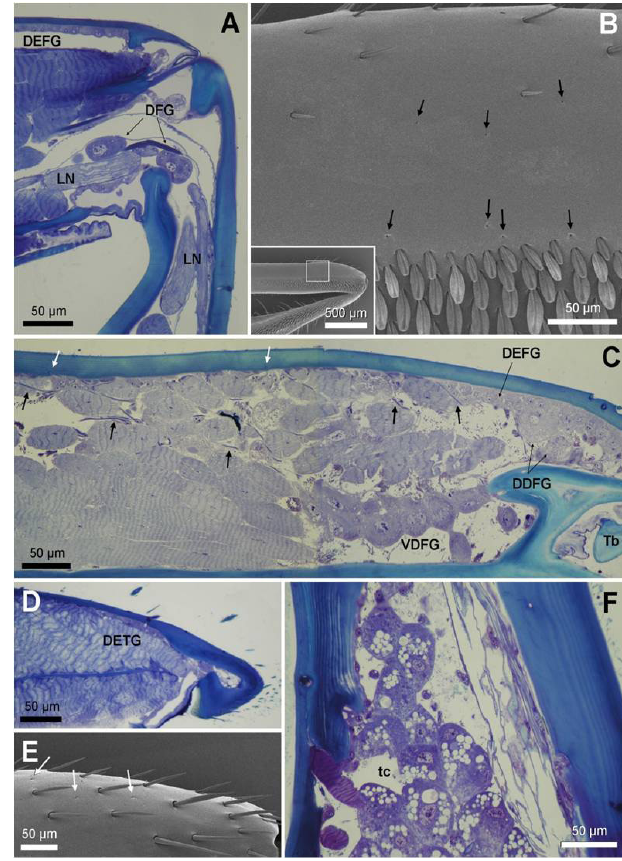
Fig 4 . A . Junction between midleg femur and tibia, showing the dor- sodistal epithelial femoral gland (DEFG) and distal femoral gland (DFG). B . Scanning micrograph of hindleg femur, arrows indicate duct openings of the dorsodistal femoral gland (inset shows region where picture is taken). C . Section through distal region of hindleg femur. Arrows indicate long ducts of the ventrodistal femoral gland (VDFG; white arrows show ducts penetrating cuticle). D . Distal part of foreleg tibia with dorsodistal epithelial tibial gland (DETG). E . Scanning micrograph of foreleg tip, arrows indicate duct openings of the dorsodistal tibial gland. F . Distal region of hindleg tibia with numerous probably non-glandular tibial cells (tc). DDFG: dorsodis- tal femoral gland, LN: leg nerve, Tb: tibia.